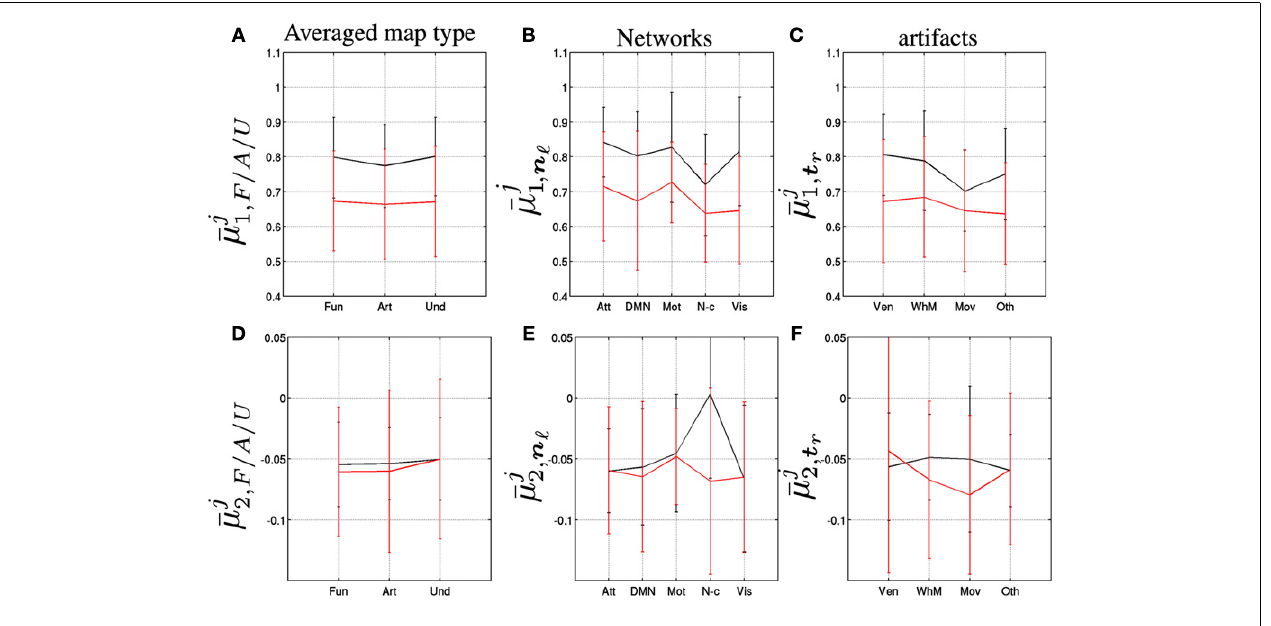
grand-mean multifractality parameter ¯ μ j averaged over the F/A/U-maps, i.e., 2, k 1 , k k ∈ F / A / U (D) , the functional networks, k ∈ N (E) and the artifact types, k ∈ T , (F) . Black and red curves code for j=R (Rest) and j=T